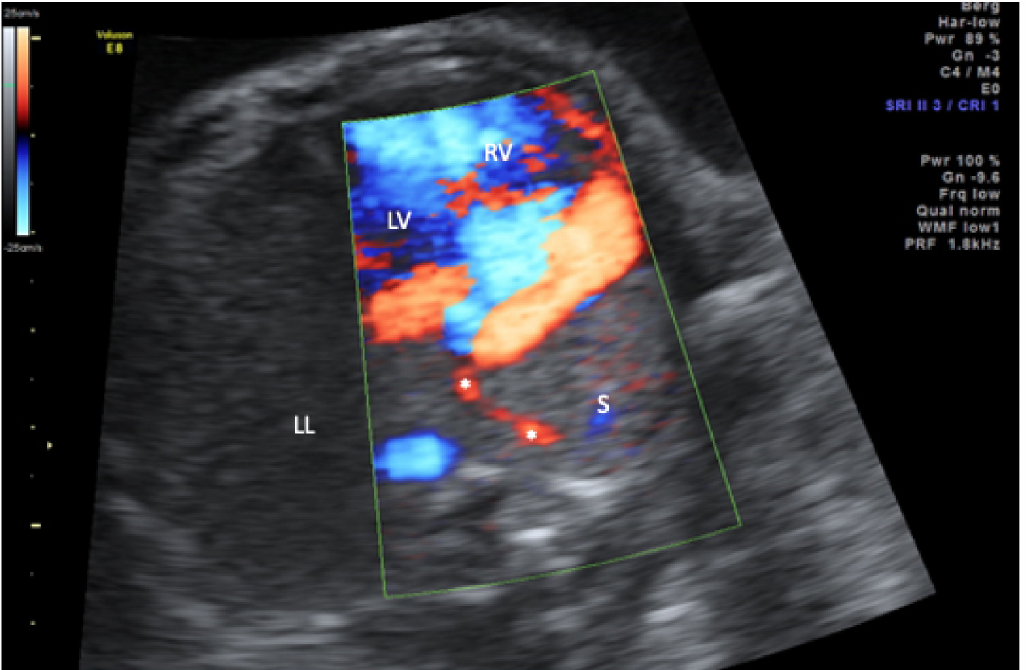
Figure 2. Transverse thoracic view in color-mode demonstrating the scimitar vein (asterisk) draining the sequestration (S) into the inferior vena cava (not displayed). LL, left lung; LV, left ventricle; RV, right